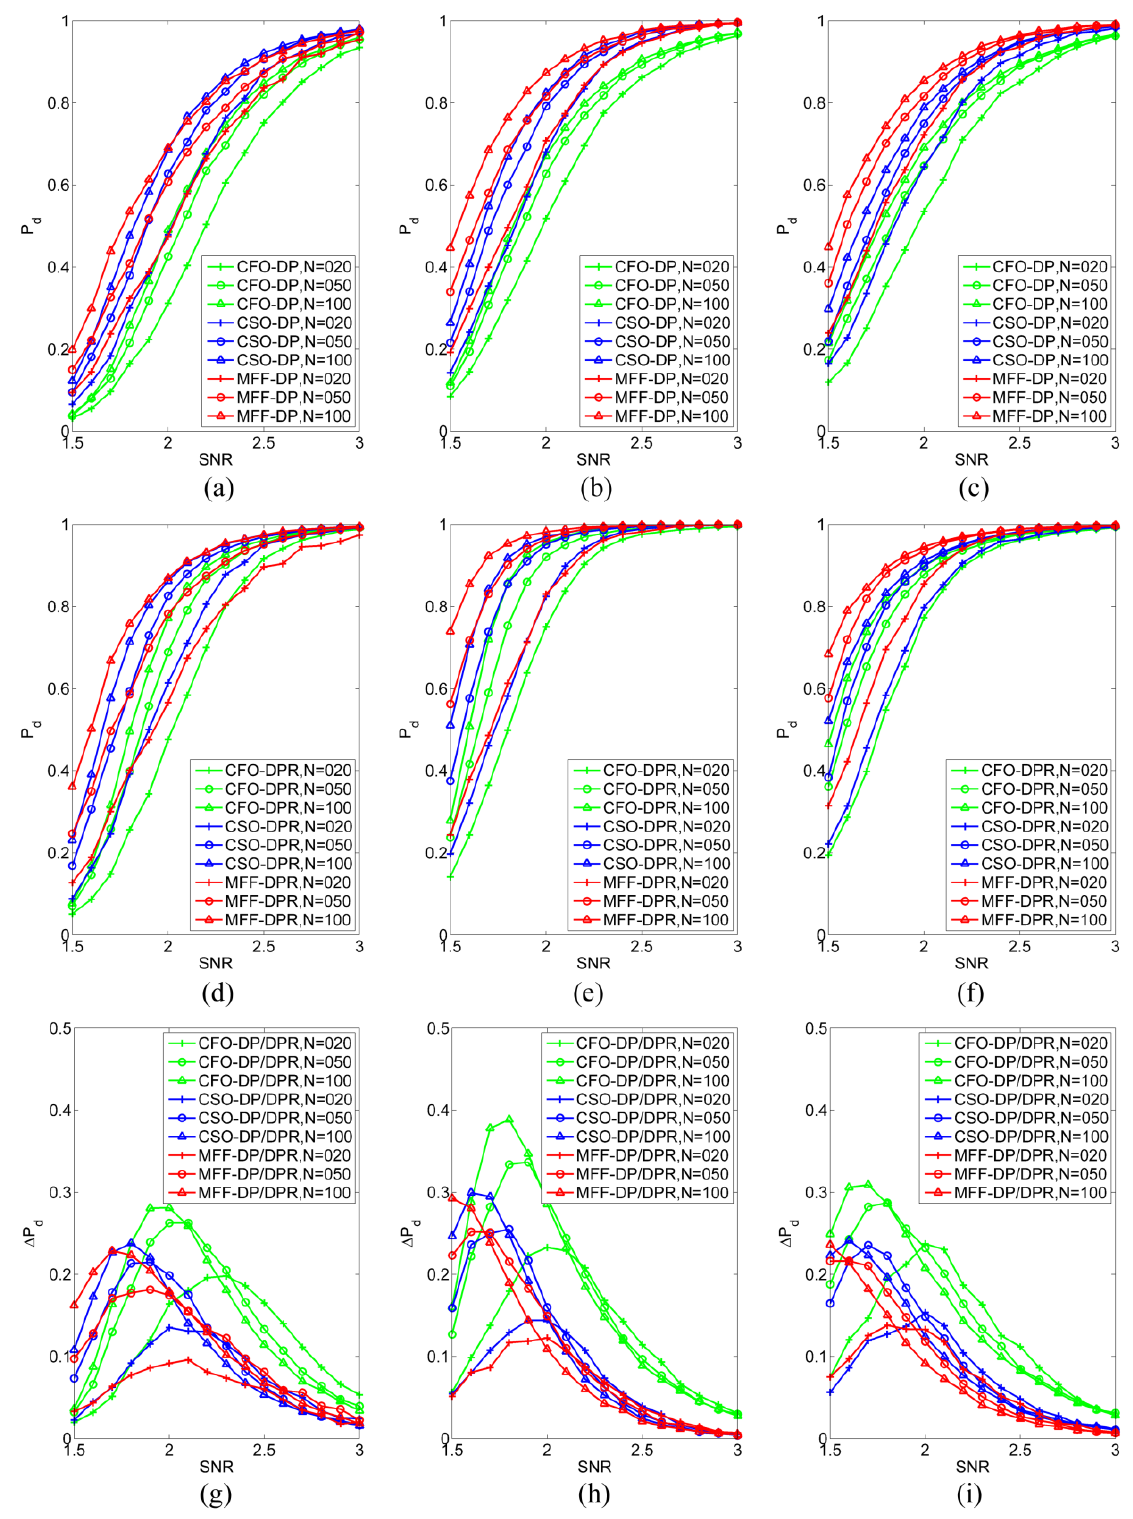
Figure 6. Single-target detection probabilities of different DP/DPR algorithms. ( a – c ) Detection probabilities of the DP algorithms; ( d – f ) detection probabilities of the DPR algorithms; ( g – i ) detection probability differences between the DPR and DP algorithms; ( a , d , g ) test case 1; ( b , e , h ) test case 2; ( c , f , i ) test case 3.